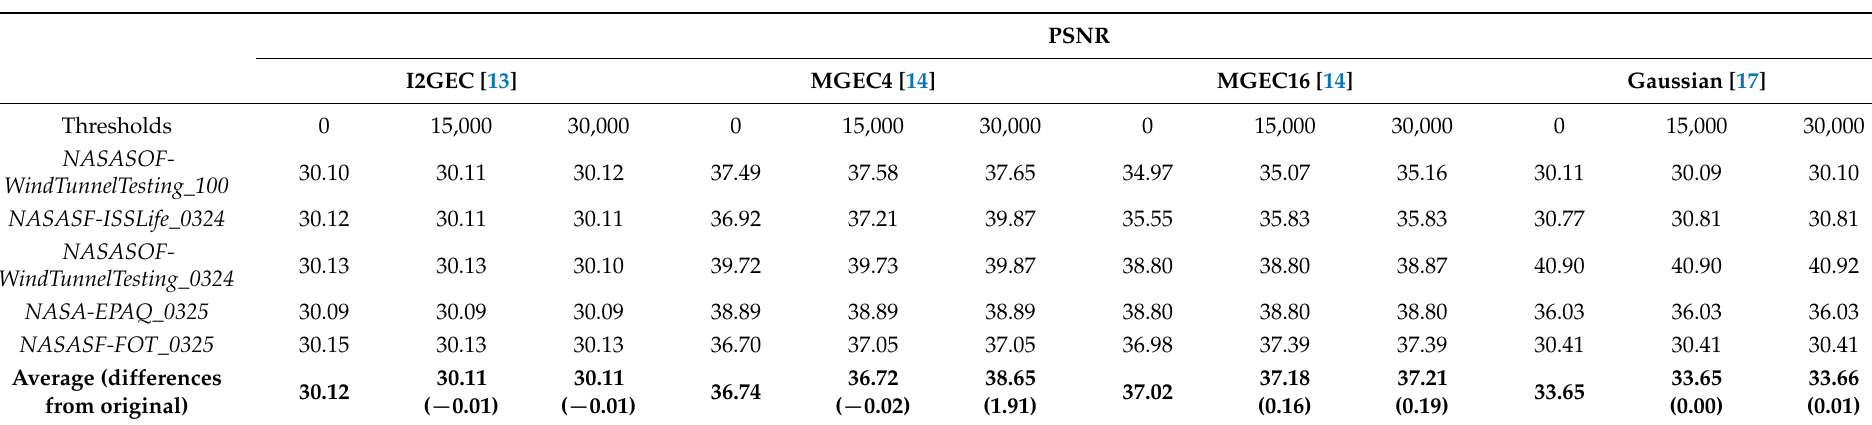
Table A2. PSNR (db; to the second decimal place) of different algorithms at different